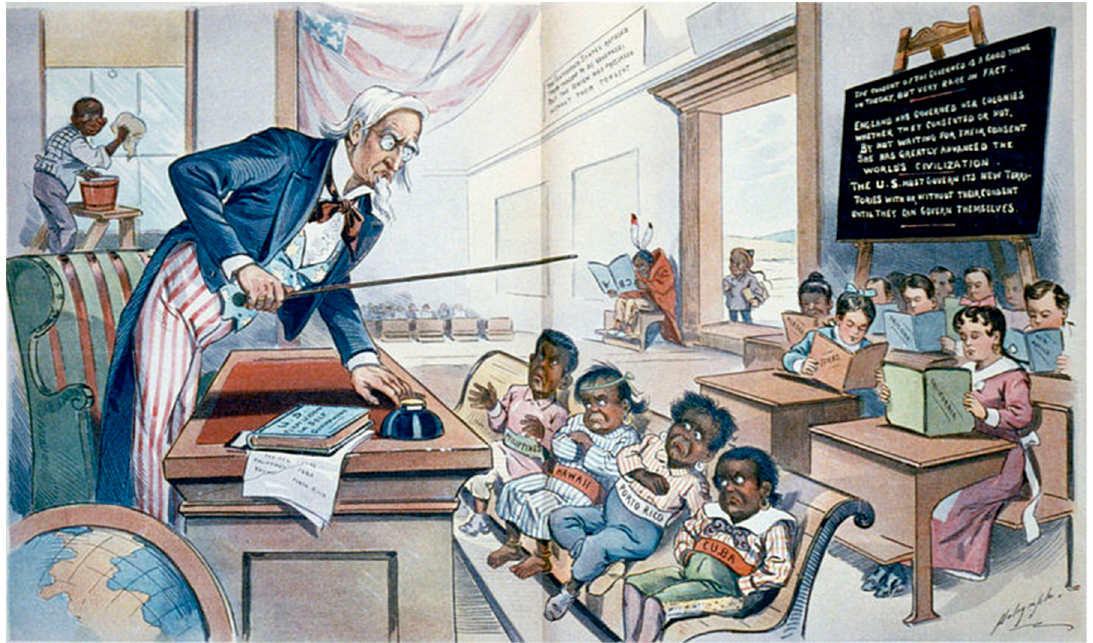
Figure 2. School Begins: Uncle Sam lectures his class in Civilization, Image in the Public Domain Created by Louis, Published by Dalrymple Puck Magazine in 1899.